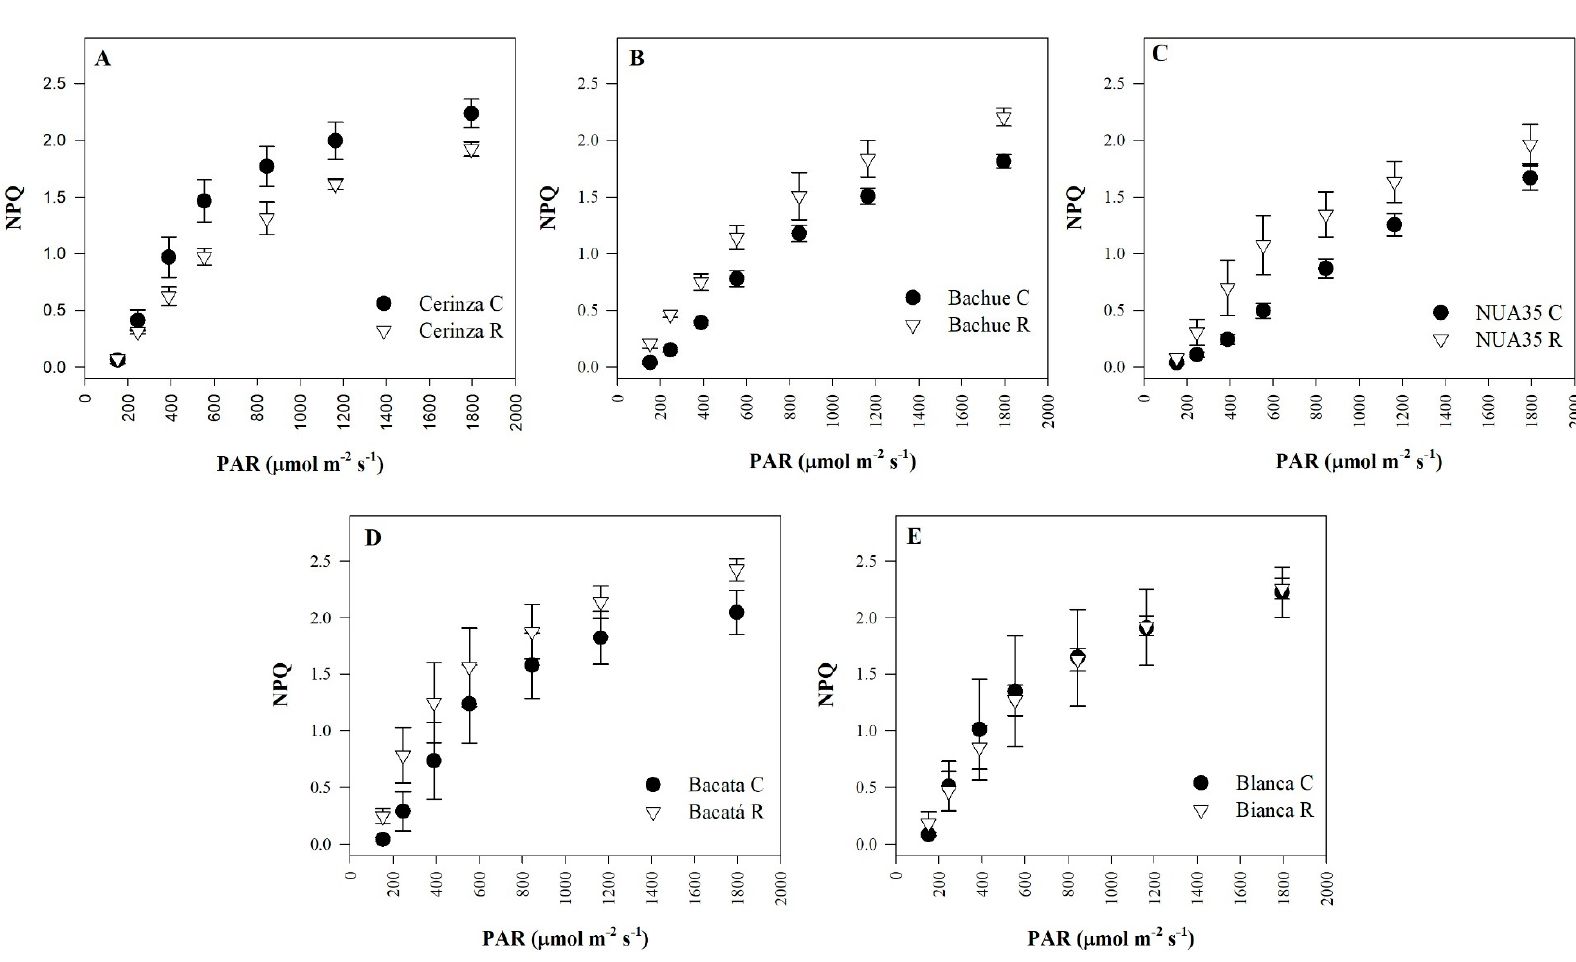
Figure 7. Non-photochemical quenching (NPQ) obtained from rapid light-response curves of ‘Cerinza’ ( A ), ‘Bachue’ ( B ), ‘NUA35’ ( C ), ‘Bacata’ ( D ) and ‘Bianca’ ( E ) under two water treatments (control ( (cid:8) ) and water-stressed ( (cid:53) ) plants) at the end of reproductive stage (65 DAE). Data represent the mean of four data points ± standard error.